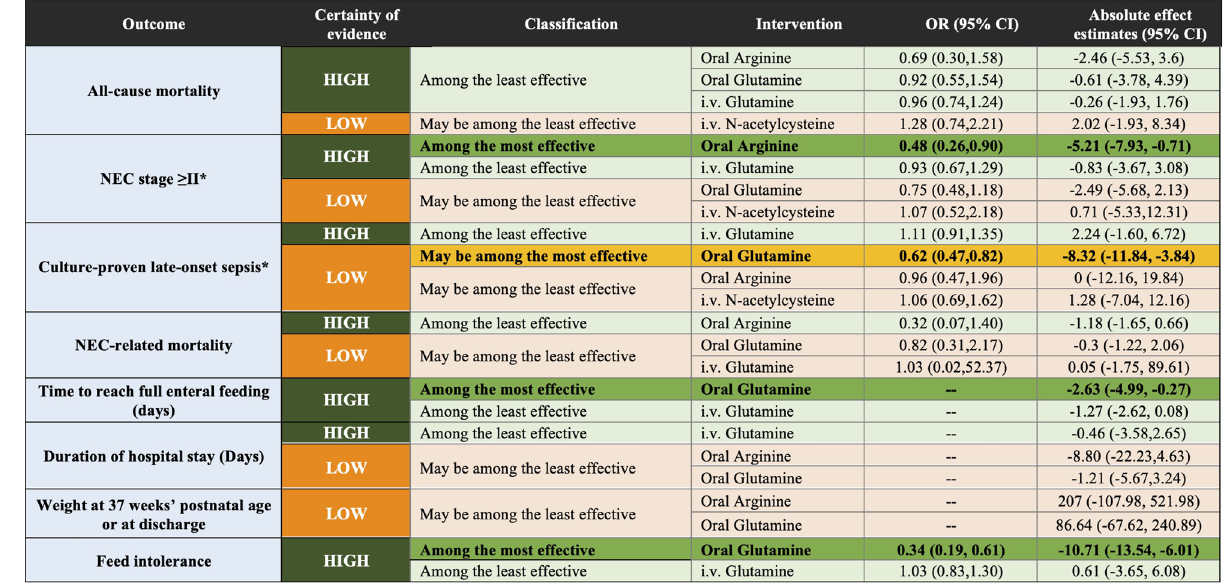
Figure 4. Network meta-analysis summary results sorted based on GRADE certainty of evidence and treatment effects for the comparisons of active treatments versus placebo for all outcomes. NMA results are sorted based on the GRADE certainty of the evidence for comparing active treatments versus placebo for all outcomes. (see “Summary and Certainty of the Results” subsection in the Methods section for more details about the categories). In the second column, green cells denote high certainty of the evidence, and orange cells denote low certainty of the evidence. In columns three to six, dark green denotes that with high certainty the intervention is among the most effective; light green denotes that with high certainty the intervention is among the least effective; dark orange denotes that with low certainty the intervention is among the most effective; and light orange denotes that with low certainty the intervention is among the least effective. We present the relative and absolute effect estimates for all-cause mortality, NEC ≥ stage II, culture-proven late-onset sepsis, NEC-related mortality, and feed intolerance. For continuous outcomes (Time to reach full enteral feed in days and duration of the hospital stay), results are the mean difference (absolute effect). In bold, interventions that showed statistical significance in comparison to placebo. 95% CI 95% confidence interval, GRADE Grading of Recommendations, Assessment, Development, and Evaluation, i.v. intravenous, NEC necrotizing enterocolitis. *For NEC and sepsis, results are from fixed-effect